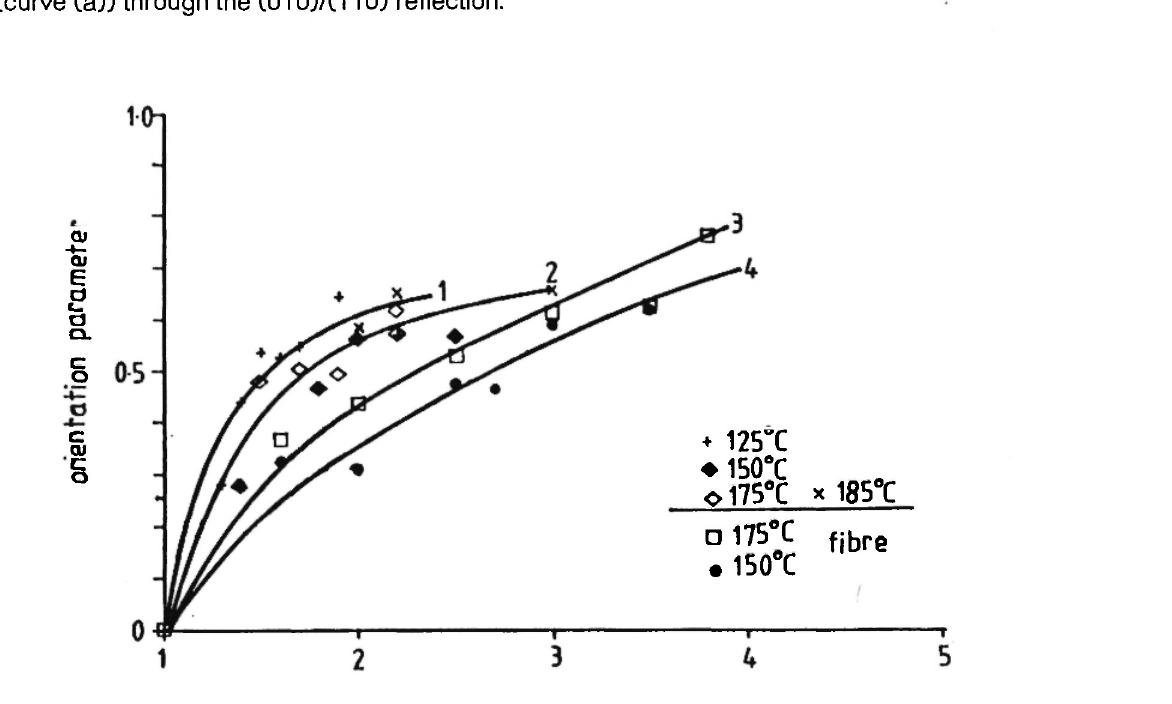
Fig. 9: Orientation parameter against draw ratios at different draw temperatures In draw 5% SCFR Nylon-6,6 composite at different draw temperature (curves 1 and 2) compared with the drawn neat Nylon-6,6 fibres at the temperatures of 150°C and 175°C (curves 3 and 4) Π